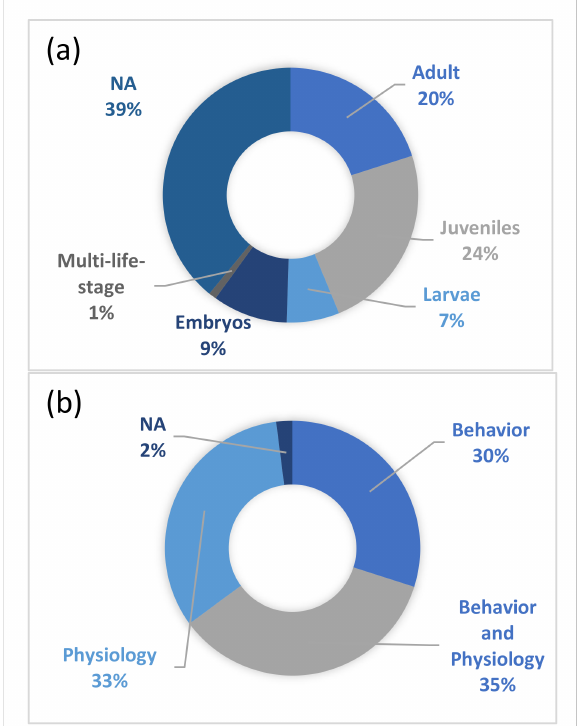
Figure 5. Publications classified by ( a ) life stage of the fishes being studied and ( b ) parameters tested. NA represents papers in which the information was not provided.